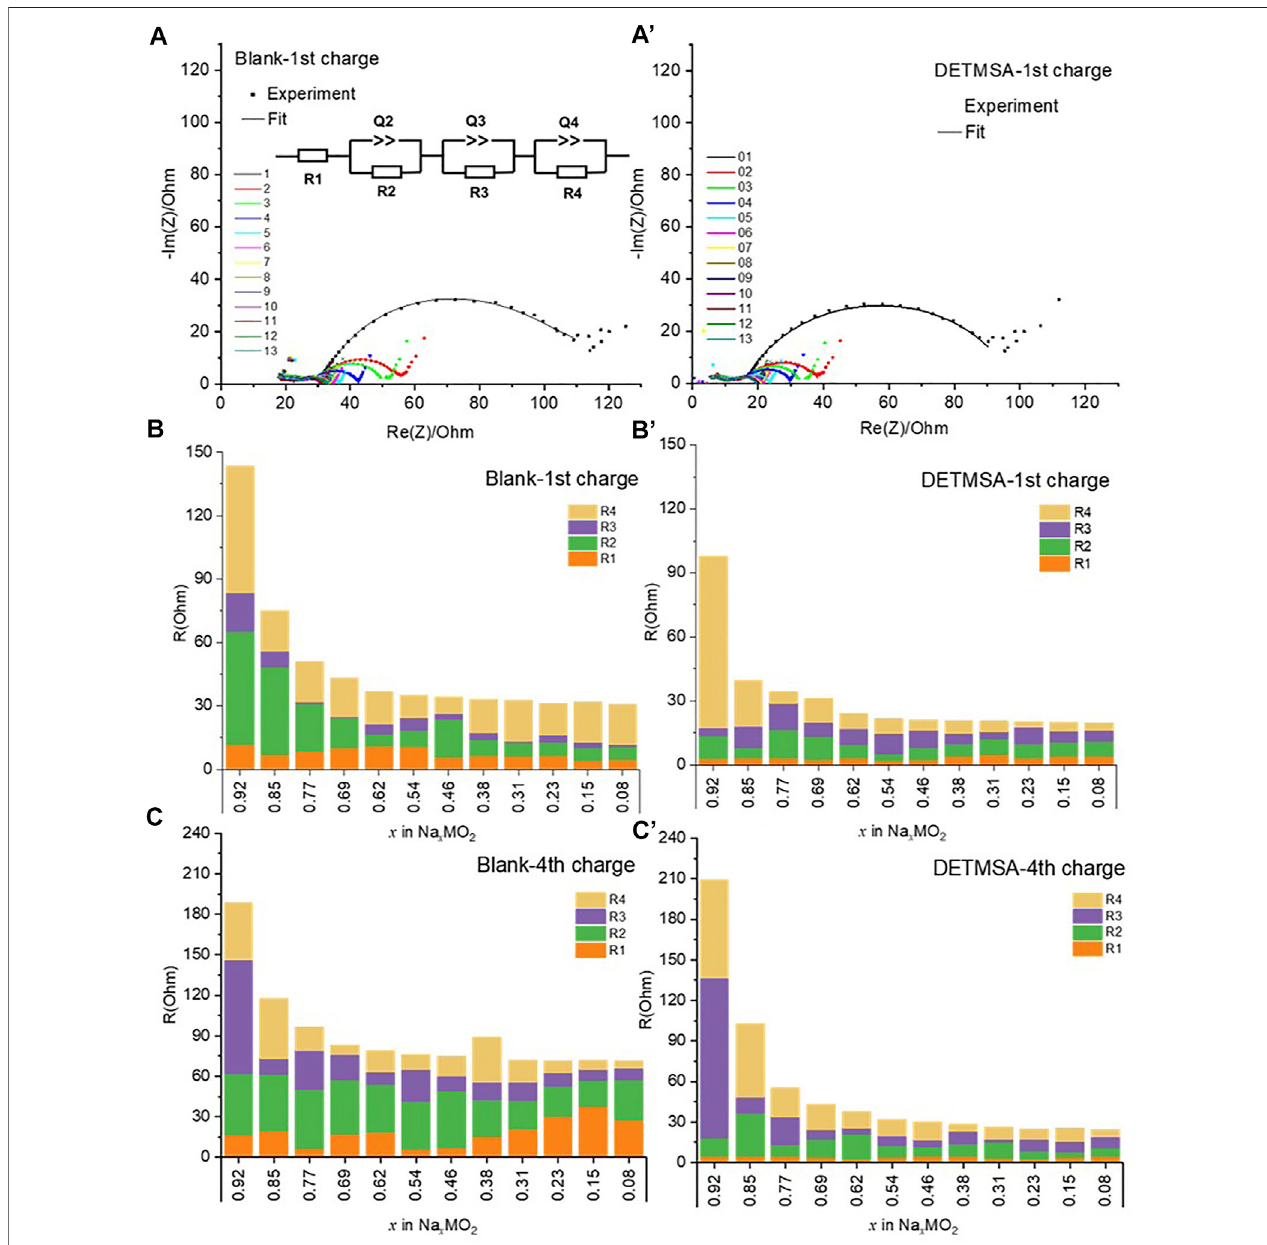
FIGURE 5 | Impedance spectra (1 – 10 mHz) of NaMO 2 /HC at different states of charge (SOC = 100 – 0%) during the fi rst and fourth charging processes and the resistance parameters at different x values in NaxMO 2 with different electrolytes: (A) , (B) , and (C) with blank electrolyte; (A ’ ) , (B ’ ) , and (C ’ ) with DETMSA electrolyte.